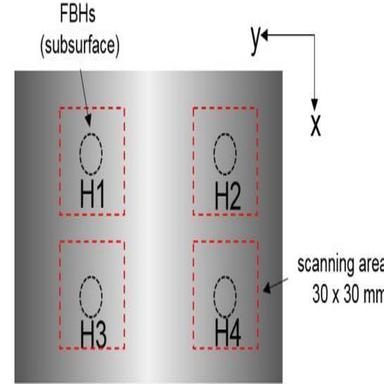
The GFRP pipe sample with 4 FBHs.